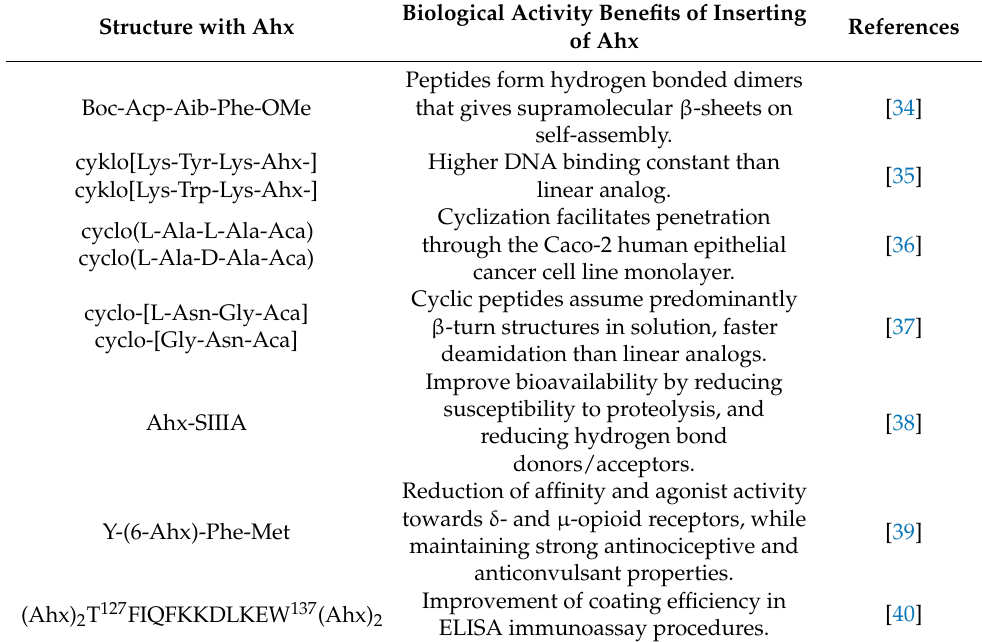
Table 2. Ahx introduction into the structure of peptides with biological activity (the original abbrevi- ations of 6-aminohexanoic acid used in the references were used in the table). Structure with